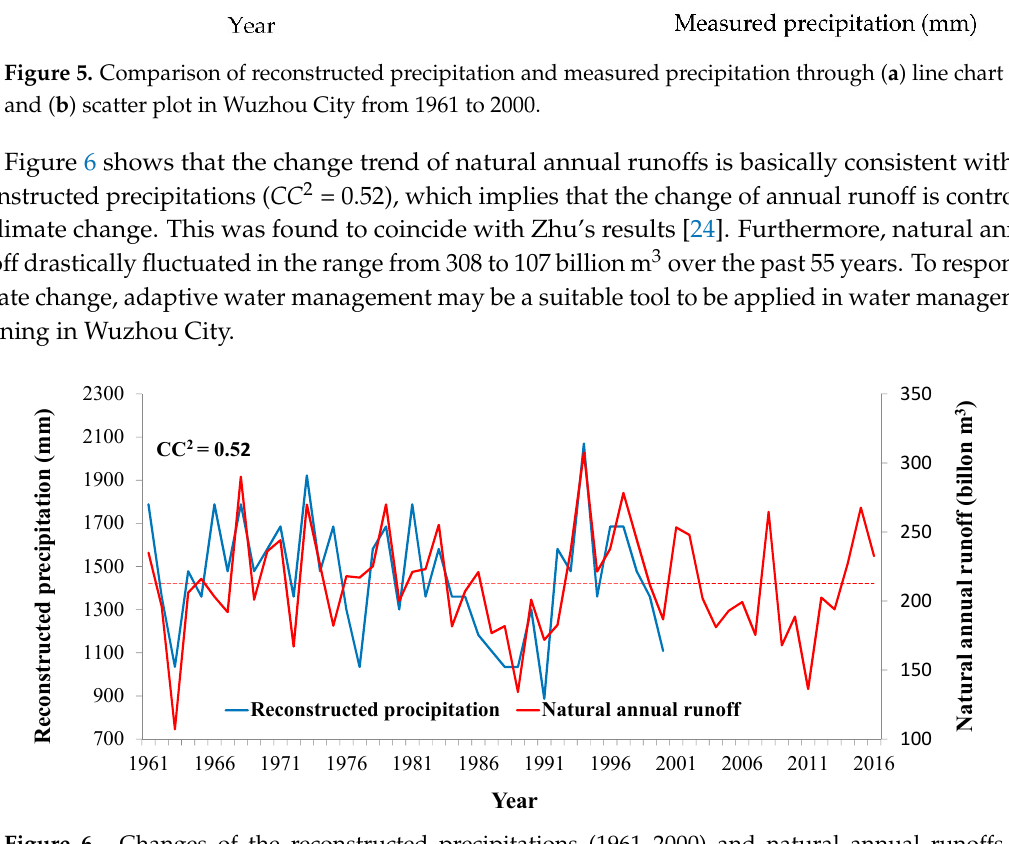
Figure 6. Changes of the reconstructed precipitations (1961–2000) and natural annual runoffs (1961–2016) at Wuzhou station from 1961 to 2000. Red broken line is the linear fit of natural annual runoffs.